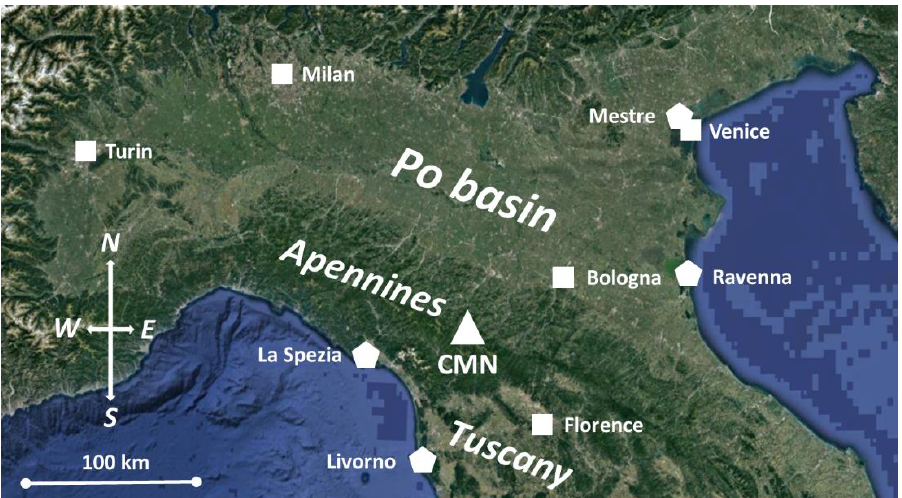
Figure 1. Geographical location of CMN (triangle) in northern Italy. Location of major urban areas (squares) and power/petrochemical plants (polygons) are also reported.